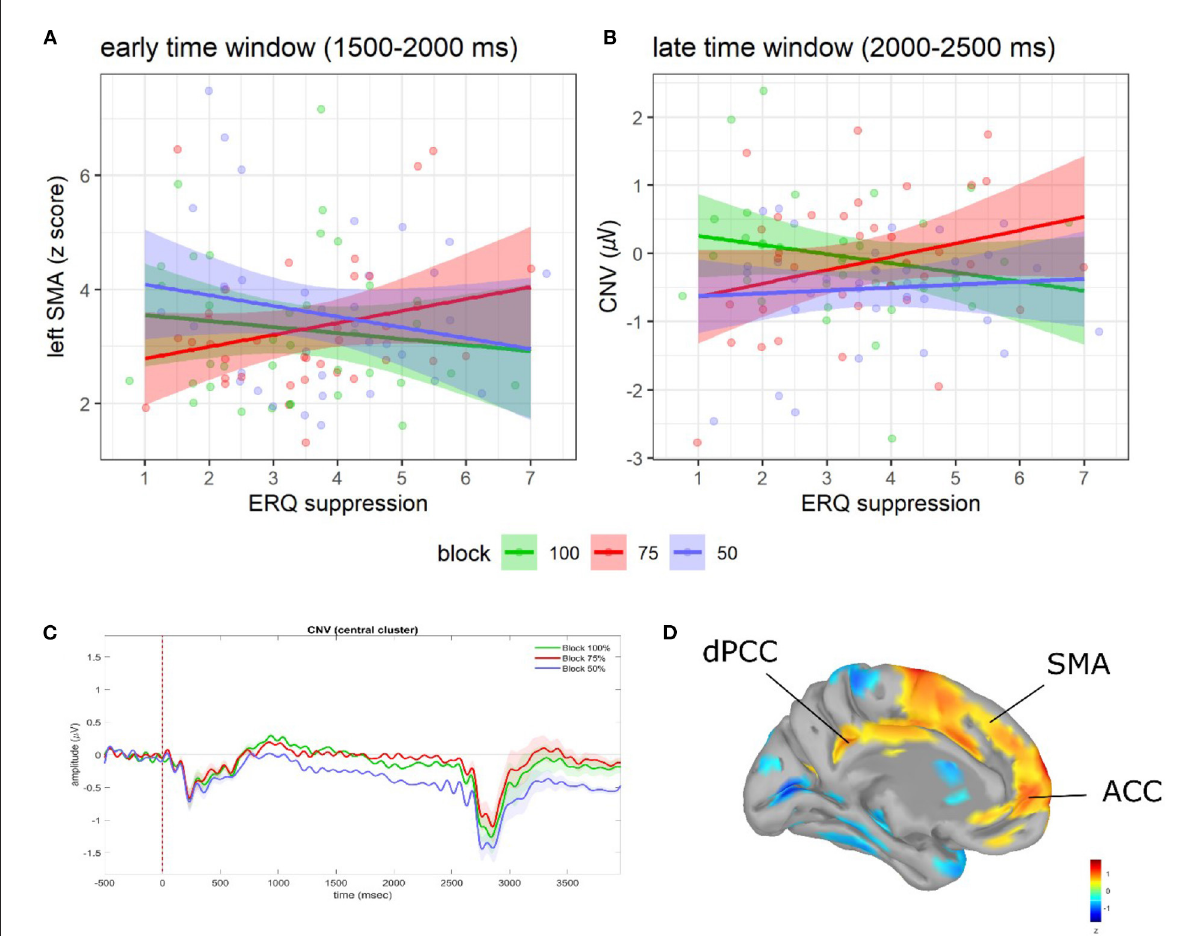
FIGURE2 Regression plots of ERQ suppression scores on (A) early l-SMA activity and (B) late CNV amplitude as a function of blocks. Shaded areas denote the 95% CI. Points represent individual observations. Grand average ERP waveforms during ISI as a function of blocks (C) . Shaded areas denote SE. For visualization purposes, waveforms were low-pass re-filtered at 10Hz. Adapted from Del Popolo Cristaldi et al. (2021d). Brain activity ( z -score) of the l-ACC, l-SMA, and l-dPCC (D)